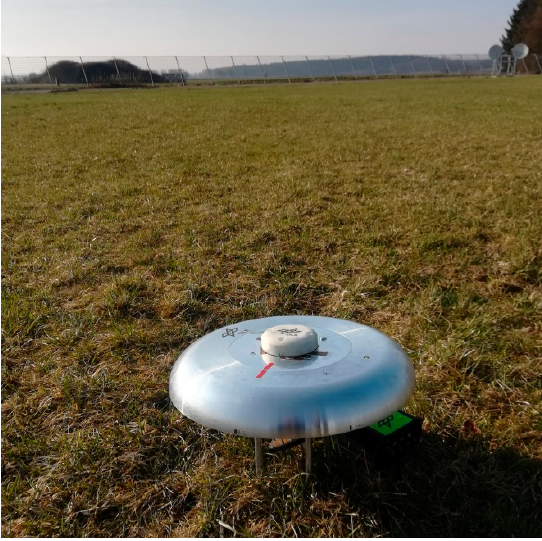
Figure 12. DLR antenna on a small ground plane and connected to a Javad receiver for GNSS field tests.